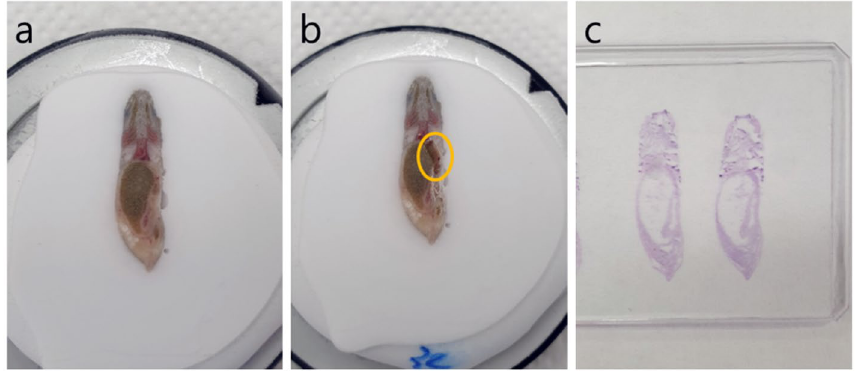
Figure 6. Frozen sections of each zebrafish with longitudinal sections were used for fat staining. (a) When the liver (circled) began to appear on the cut surface (b) of the frozen section, it was cut into serial sections with a thickness of 4 µm (c)